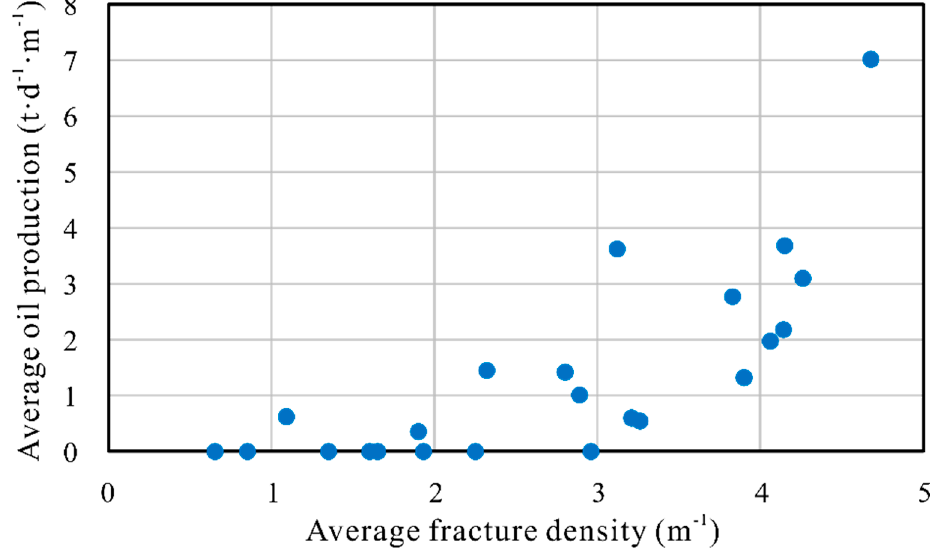
Figure 20. The relationship between the average oil production and the average fractures density in the perforated intervals. The average oil production refers to the daily production of oil in the well-testing stage in every meter perforated interval. The average fracture density is the linear density of opening-mode fractures in the perforated interval from the borehole image logs. Unit t·d − 1 ·m − 1 refers to the average number of tons of oil produced per day in one-meter perforated interval.